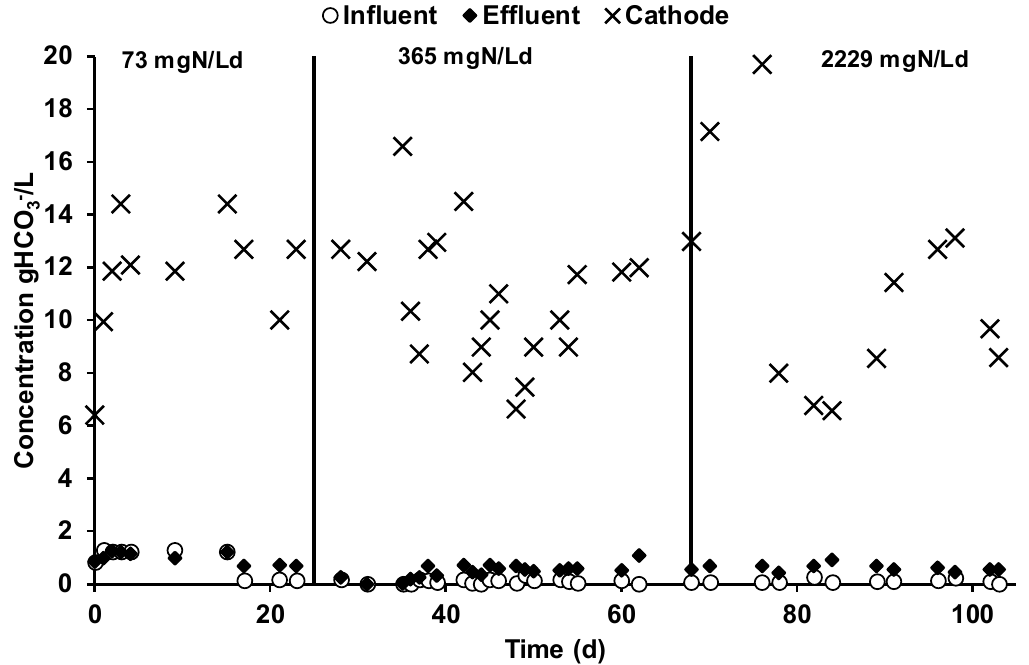
Figure 6. Bicarbonate concentration in the di ff erent MEC streams during the three di ff erent operating periods.